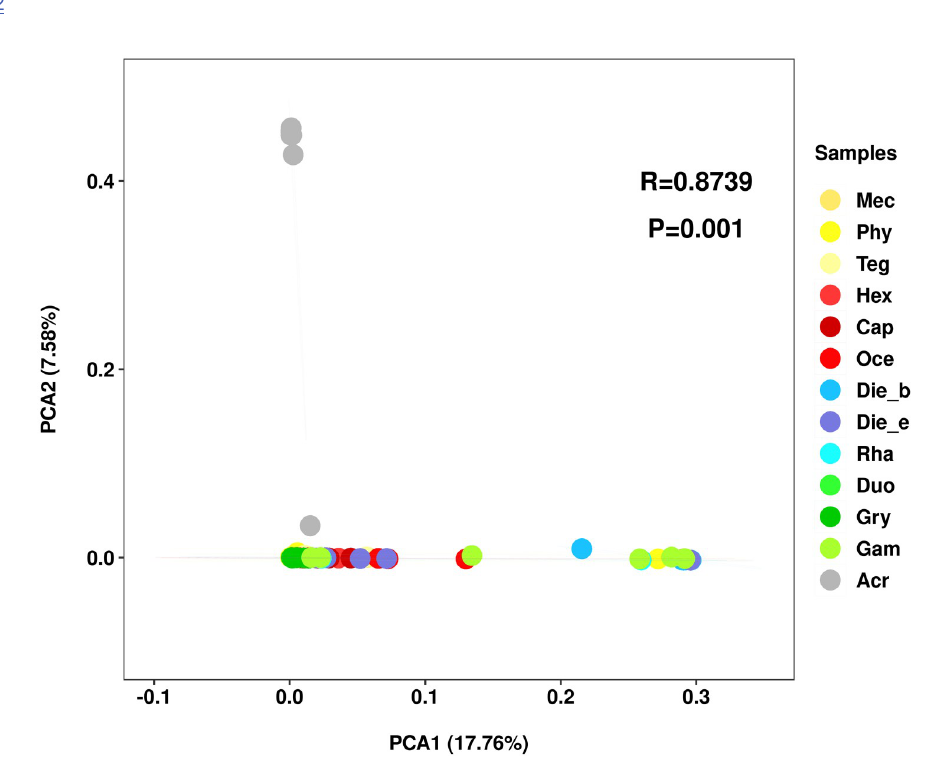
Fig 2. Bacterial communities clustered by using principal component analysis